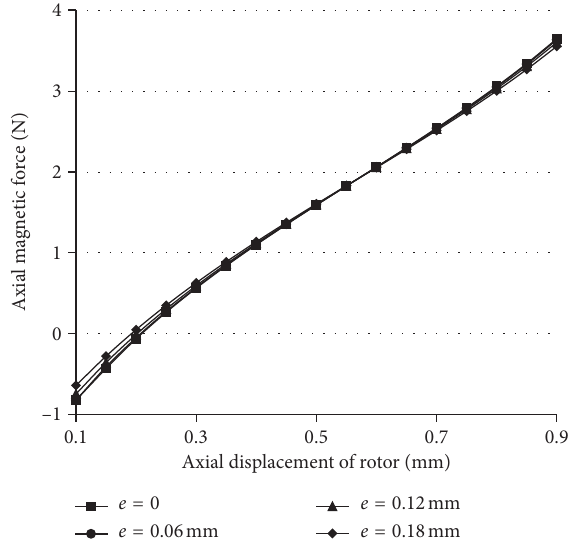
Figure 5: Axial forces of magnetic bearings acting on the rotor in different axial positions and radial